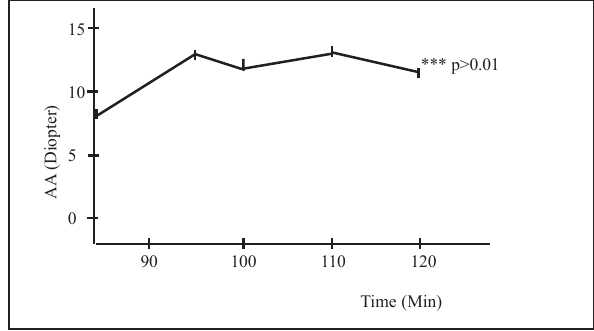
Figure 2: Changes in AA with time following acute ingestion of Cola nitida (30 g) by ten volunteers. Each point represents the mean + SEM of 5 readings ( p >0.01). The increase is small but